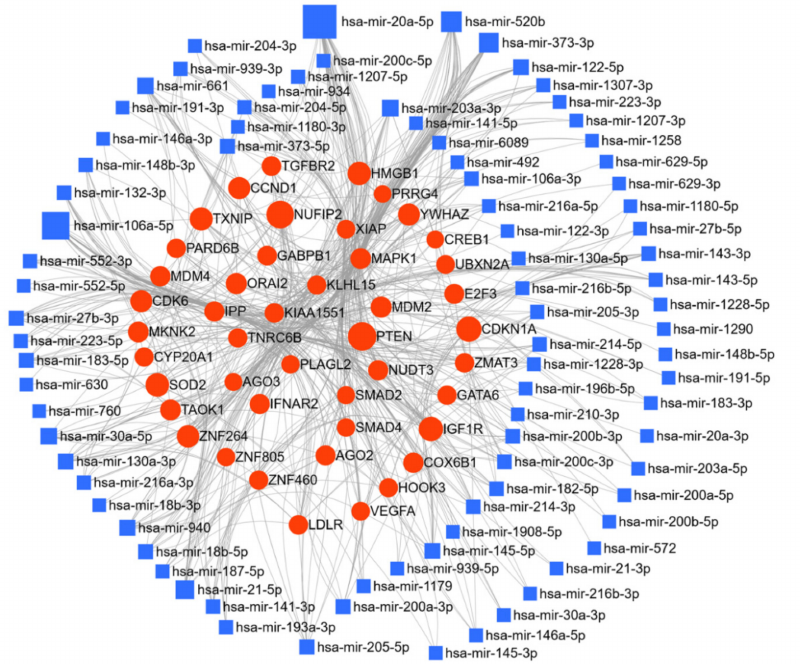
Figure 4. Network of upregulated miR in ovarian cancer: miR deregulated in ovarian cancer were searched for in the PubMed database using IRIDESCENT. The network of upregulated miR generated using miRNET (degree filter cutoff 10) is shown. The blue squares represent miR, and the red dots represent target genes of these miRs.